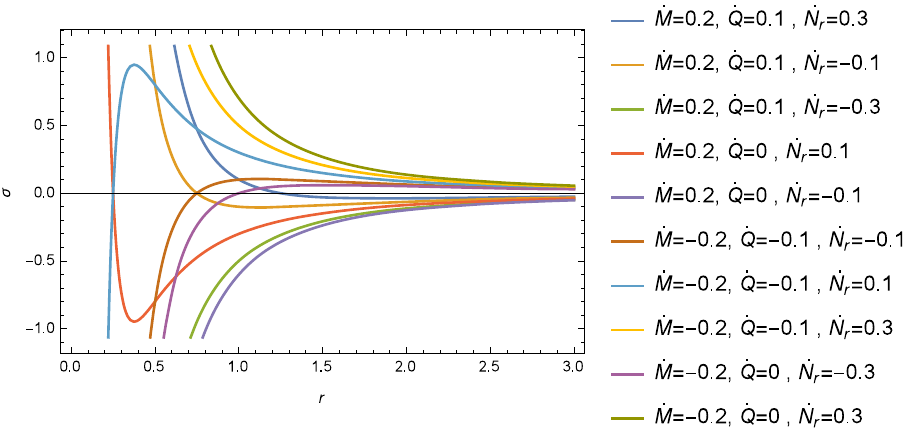
Fig. 6 Radiation-accretion density σ versus the distance